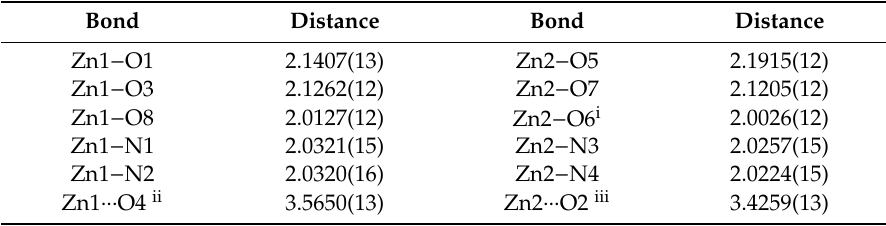
Table 2. Bond lengths to the Zn(II) ions (Å) for ( 2 ).